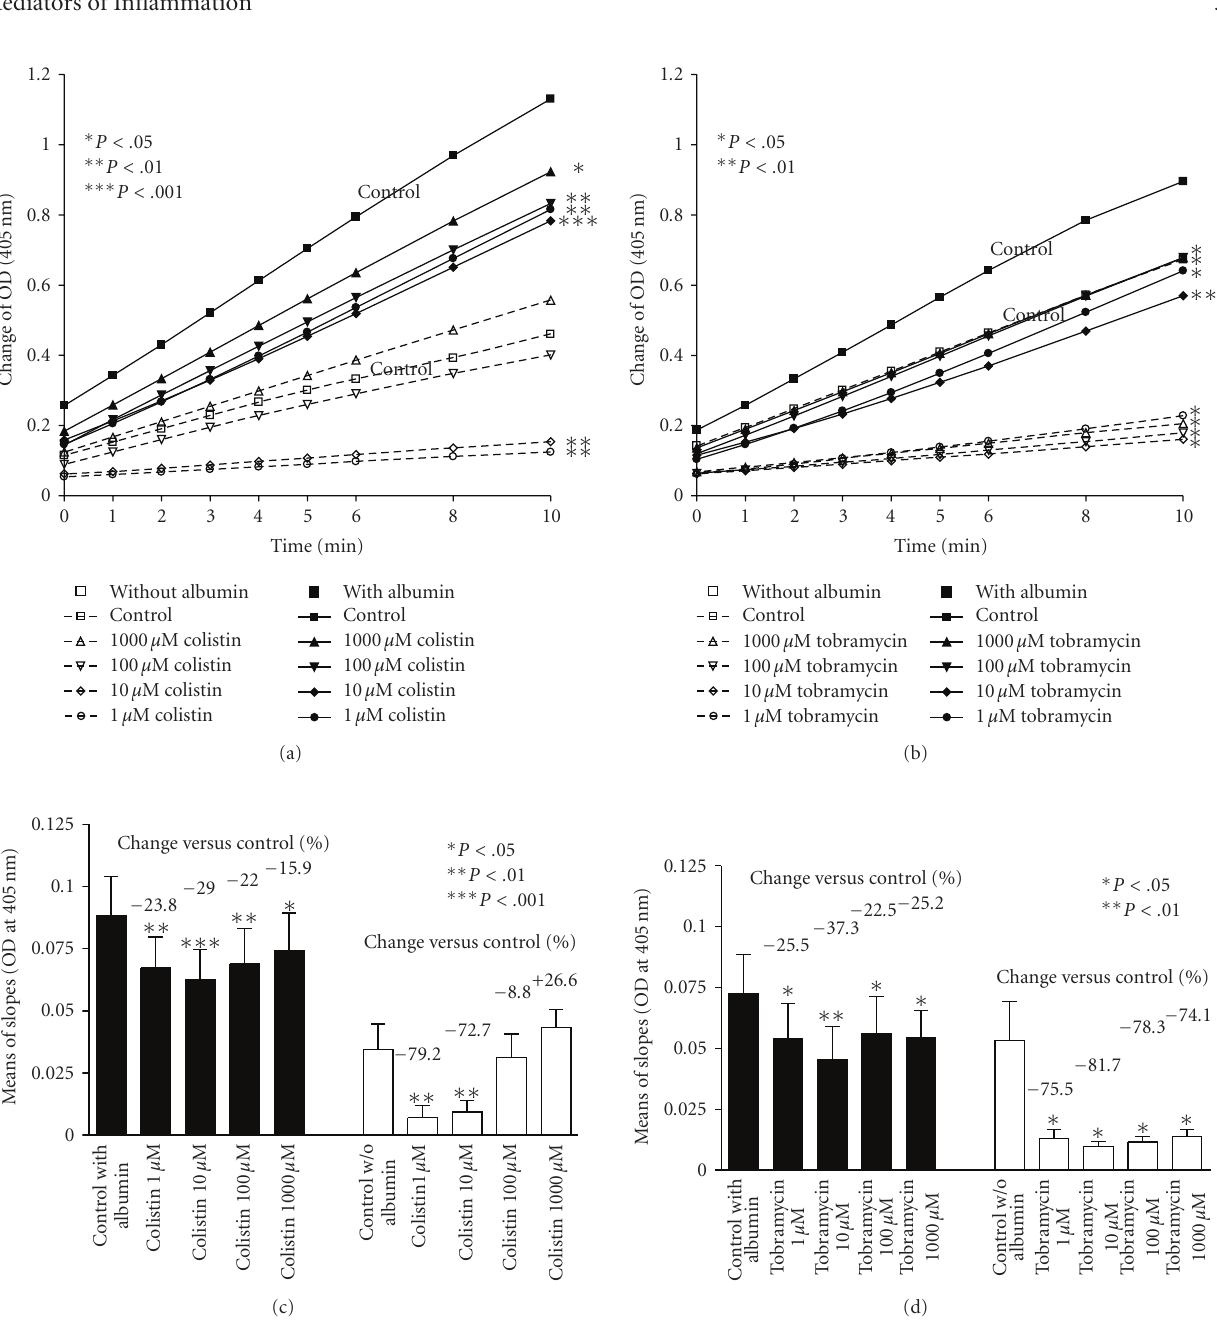
Figure 2: E ff ect of colistin (a) and (c) and tobramycin (b) and (d) in di ff erent concentrations (1, 10, 100, 1000 μ M) on neutrophil elastase activity measurements (neutrophil elastase concentration = 8 μ g/mL) in presence (filled symbols and contineous lines or filled columns) or absence (blank symbols and dashed lines or empty columns) of albumin. In Figures 2(a) and 2(b) change of optical density (OD) over time is given (mean of n = 3), in Figures 2(c) and 2(d) mean values for slopes of changes in OD over 10 minutes are expressed as means and SEM (bars) and % changes compared to respective control are given of n = 3. ∗ P < .05; ∗∗ P < .01; ∗∗∗ P < .001 compared to